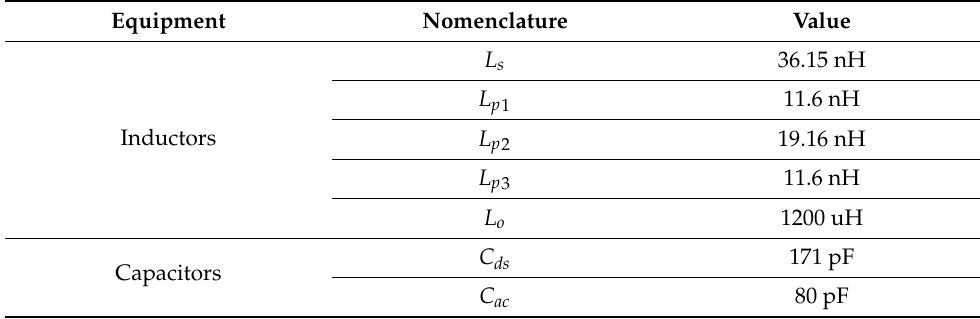
Figure 9. DPT circuit of the hybrid ANPC inverter with parasitic elements. Table 6. Parameters for DPT